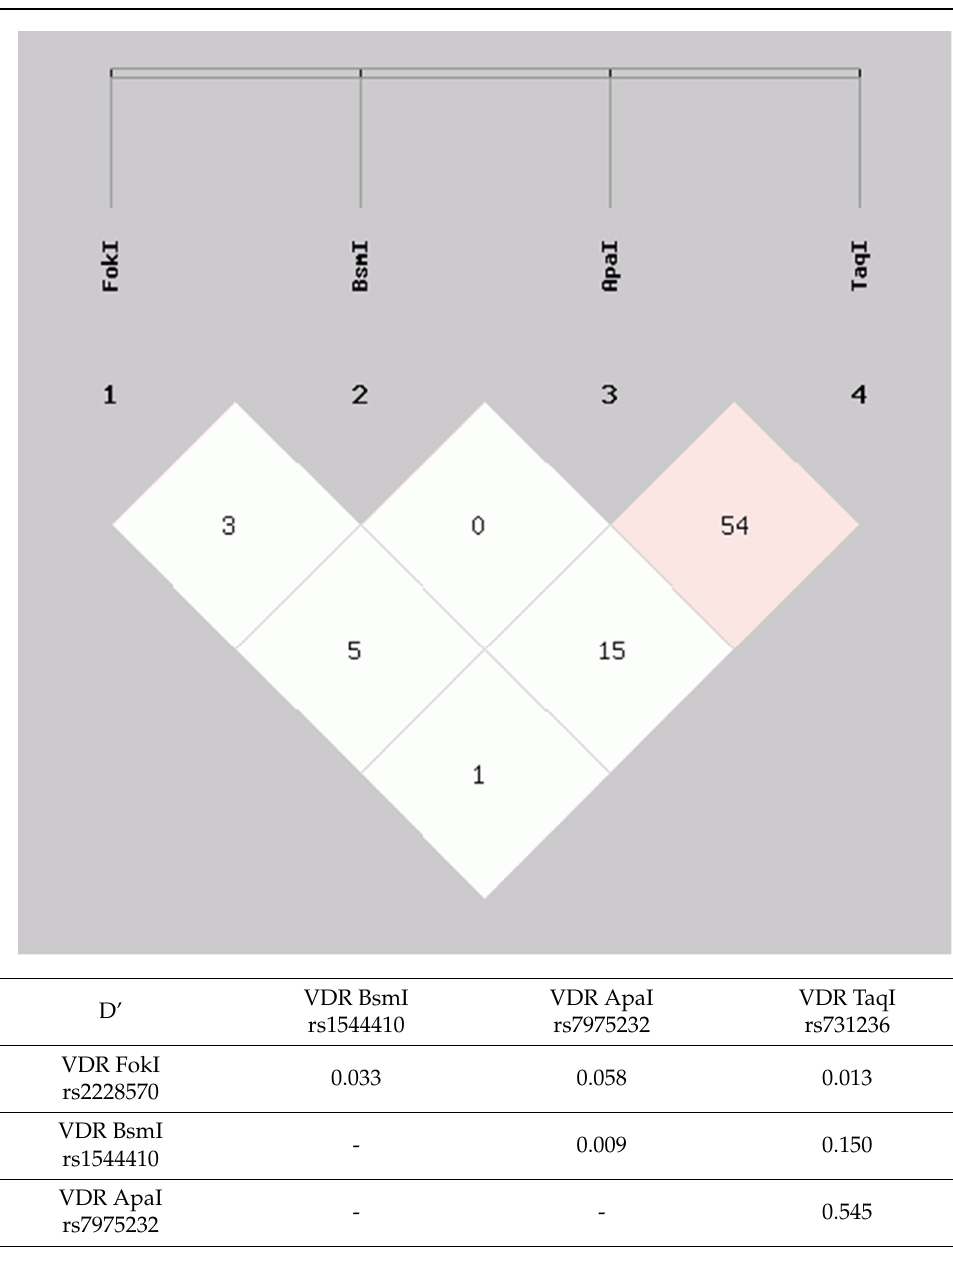
Table 5. Linkage disequilibrium coefficient (D’) of VDR SNPs typed in this study.